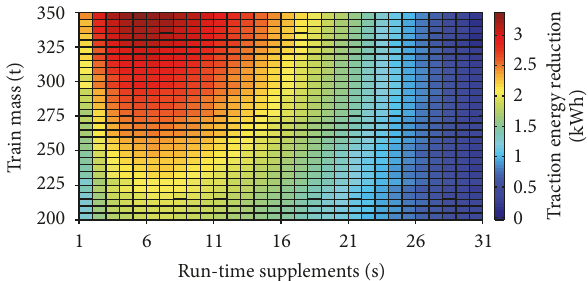
Figure 15: Traction energy reduction under various conditions using improved driving